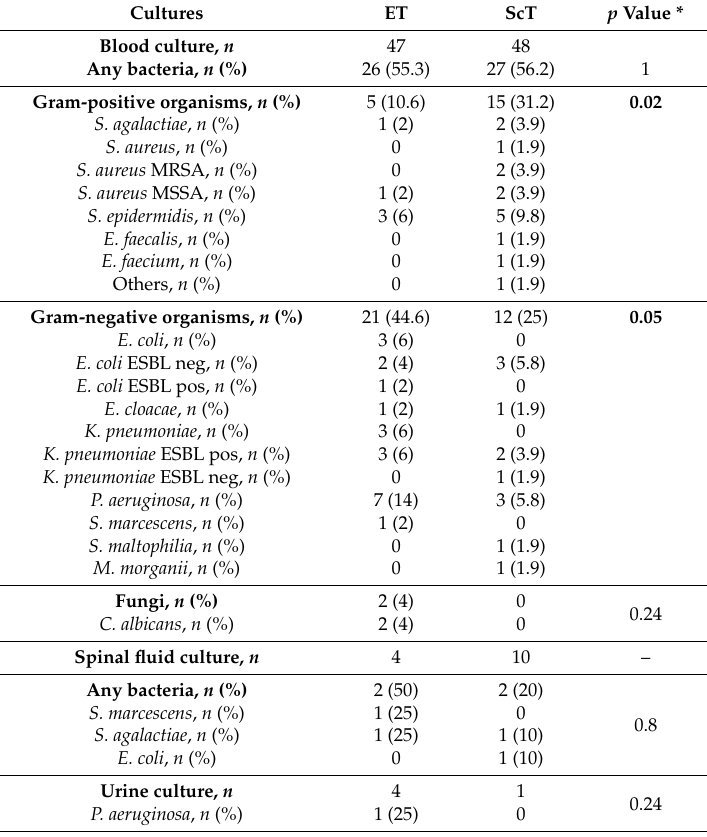
Table 2. Distribution of pathogens cultured from sterile